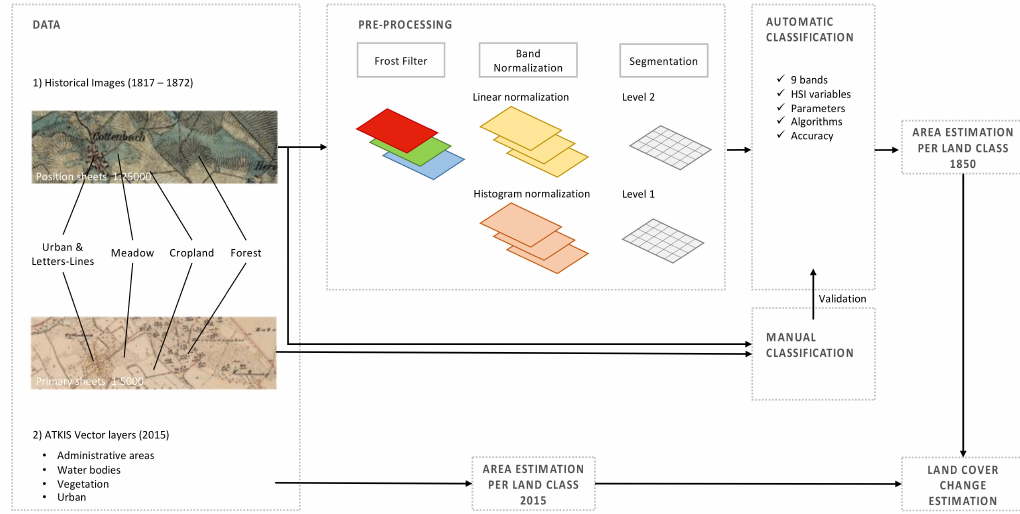
Figure 1. Flowchart of the method for land cover classification and change